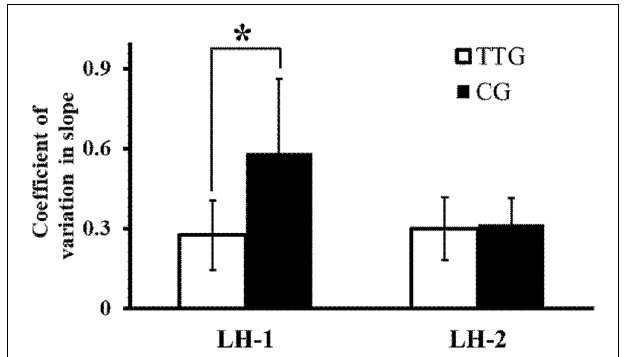
FIGURE 4 | Changes in background electromyography (BEMG) ratio. (A) Changes in BEMG of the TTG. (B) Changes in BEMG of the CG. There were no significant differences between the groups. TTG, transfer training group; CG, control